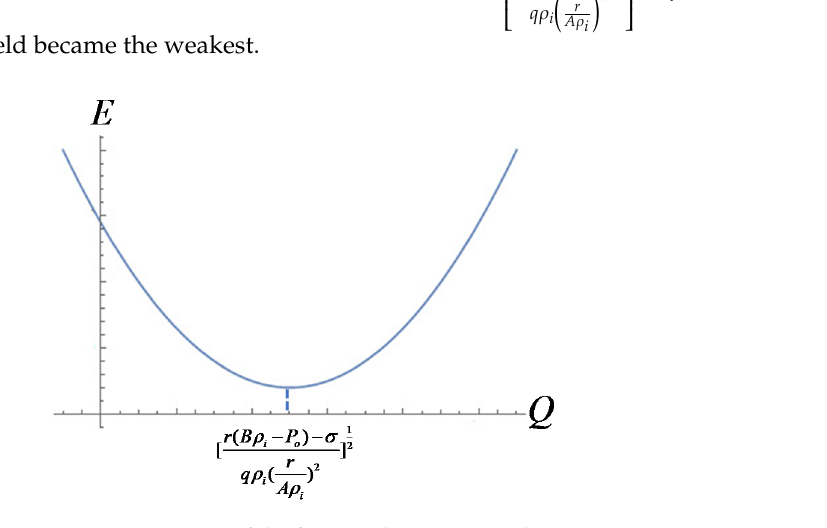
Figure 4. Diagram of the function between 𝐸 and 𝑄 .